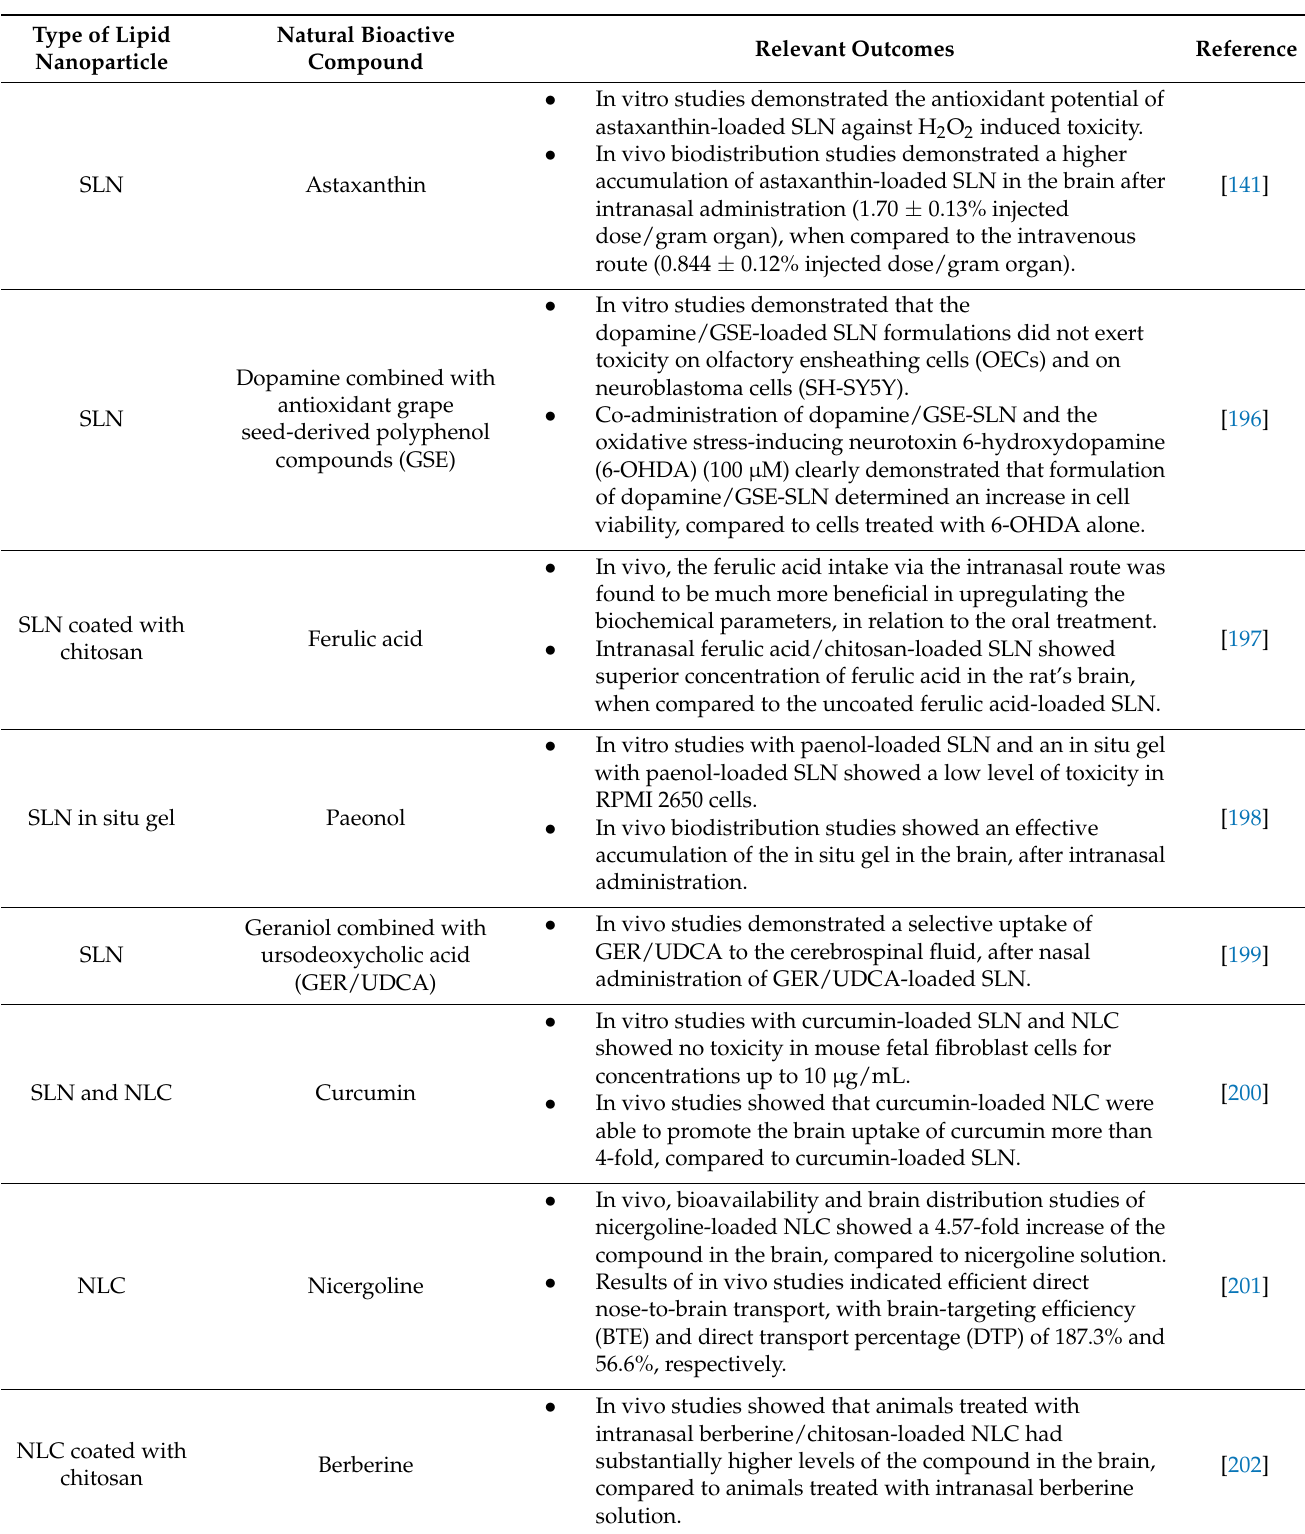
Table 3. Examples of the most relevant results from studies with natural bioactive compounds, encapsulated or on the surface of intranasal lipid nanoparticles (SLN or NLC), for the treatment of neurodegenerative